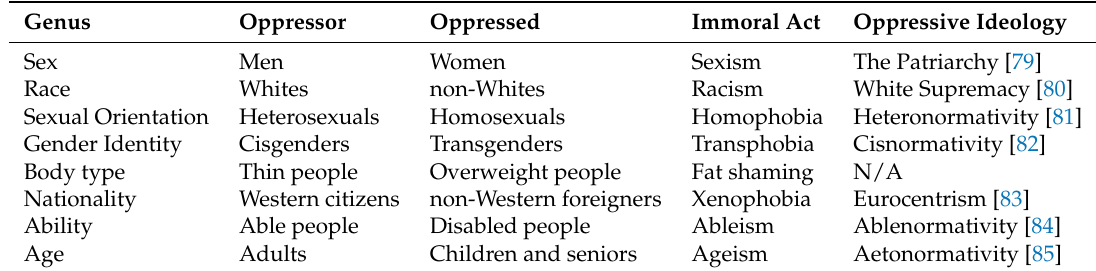
Table 1. Social Oppression in Western